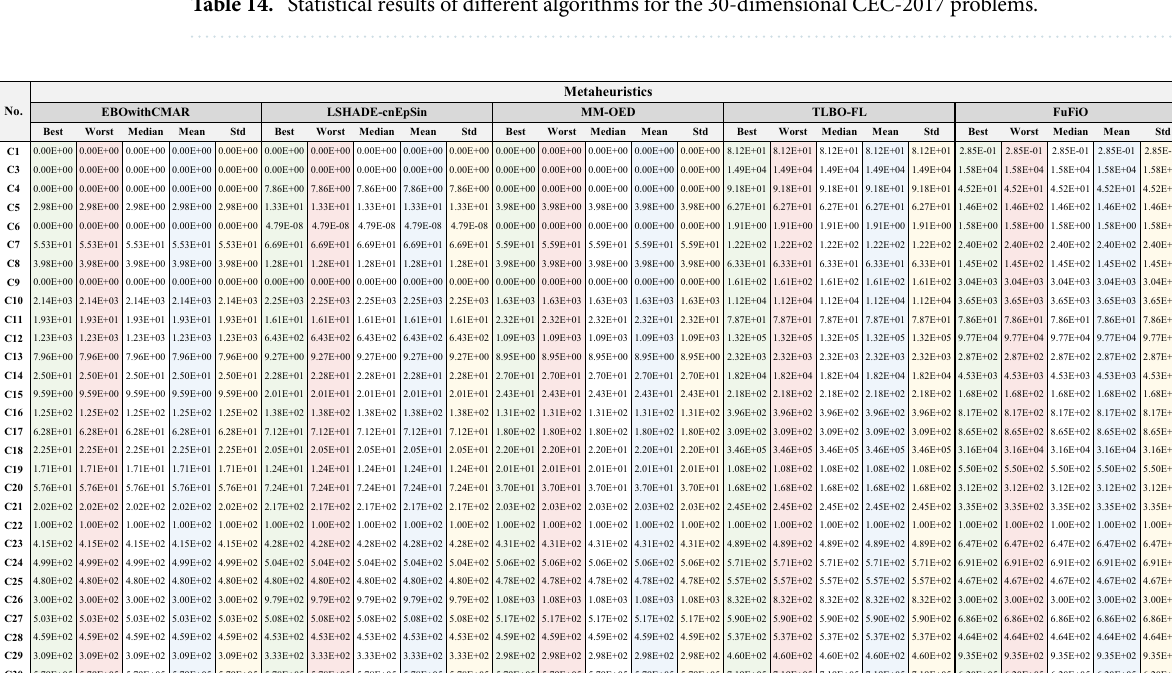
Table 14. Statistical results of different algorithms for the 30-dimensional CEC-2017 problems.